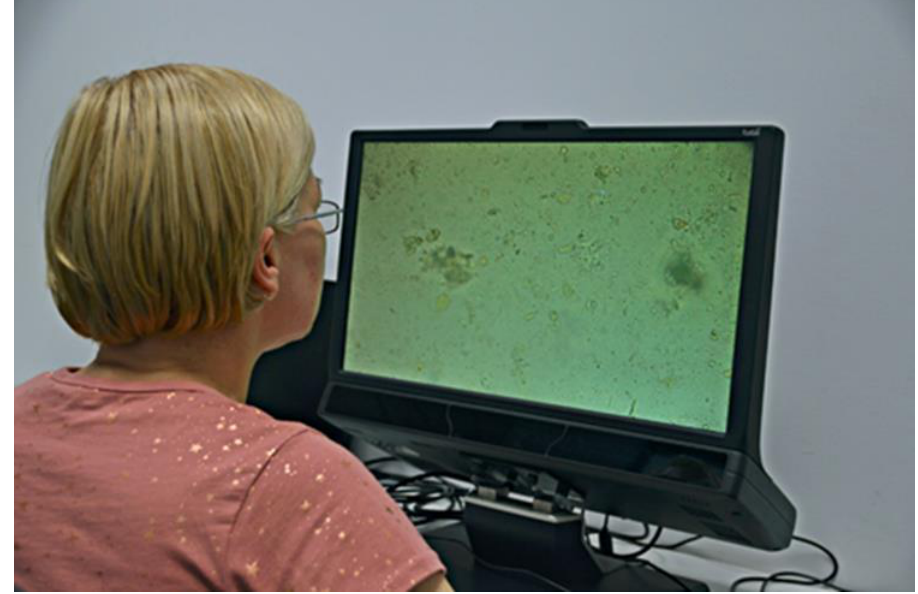
Figure 1. Eye tracking study with an eye tracker (Tobii TX300)—person controlling a digital image of a parasitological preparation, participating in the study.